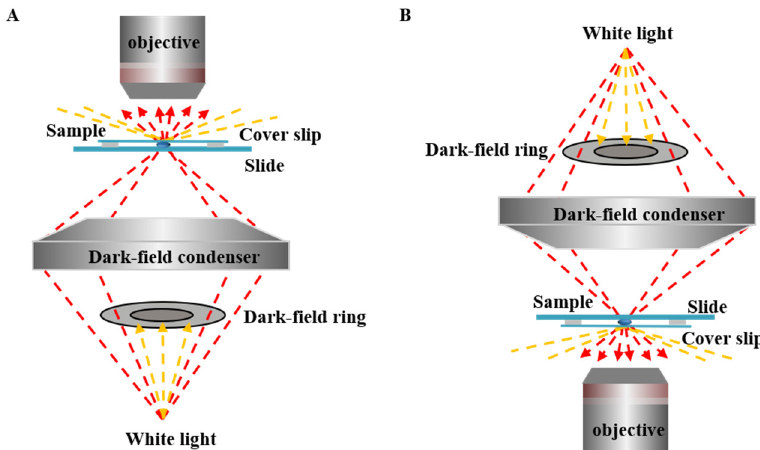
Figure 2. Upright ( A ) and inverted ( B ) types of dark-field microscope.